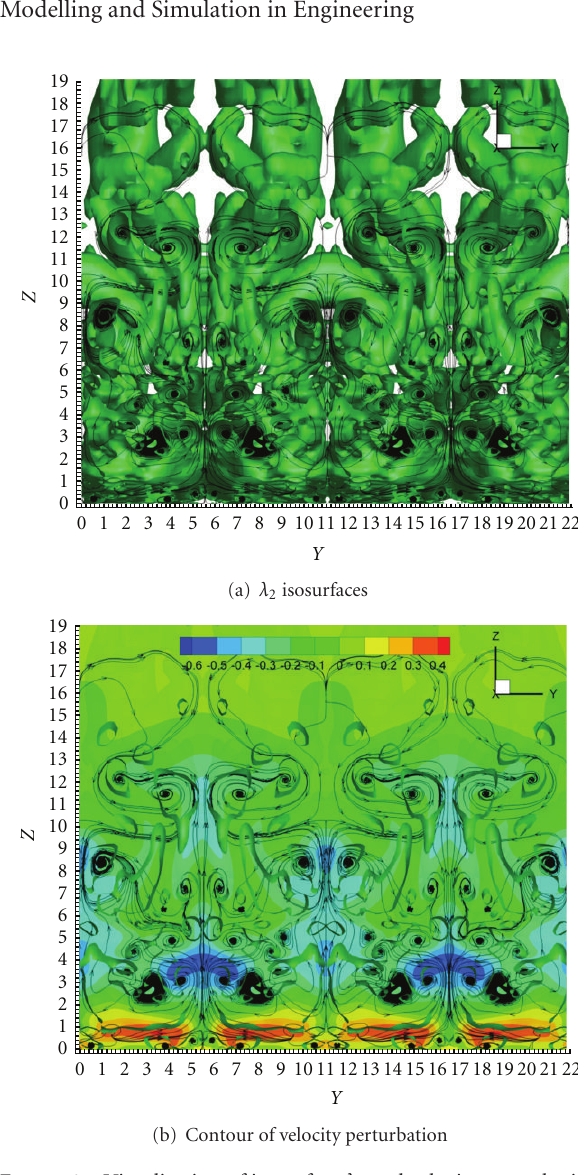
Figure 25: Visualization of isosurface λ 2 and velocity perturbation at x = 508 . 633 for ( Y , Z )-Plane t = 15 T